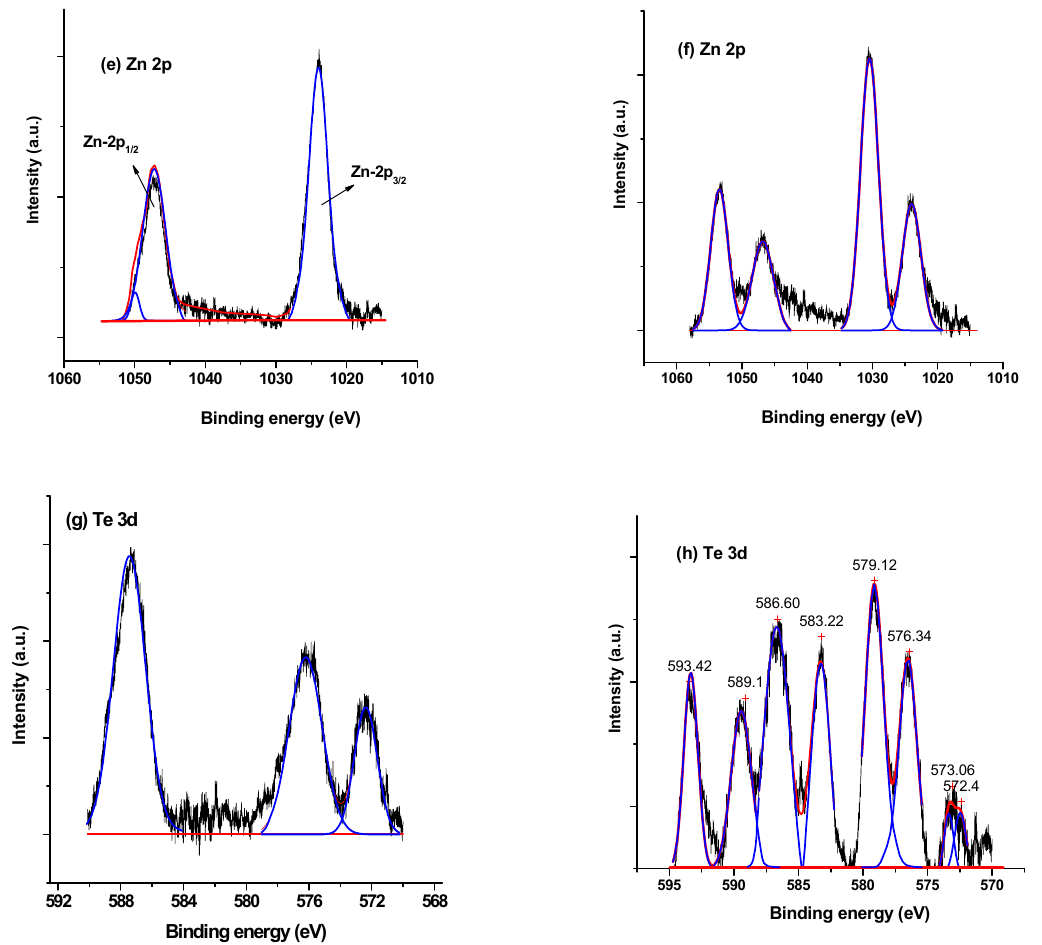
Figure 5. ( a , b ) XPS spectra of undoped ZnTe and doped with 10 at. % Cu thin films, ( c , d ) deconvo- luted XPS analysis of Oxygen-1s for undoped and Cu-doped ZnTe thin-film samples, ( e , f ) deconvo- luted XPS analysis of Zinc-2p for un-doped and Cu-doped ZnTe thin-film samples and ( g , h ) deconvo- luted XPS analysis of Tellurium-3d for un-doped and Cu-doped ZnTe thin films.